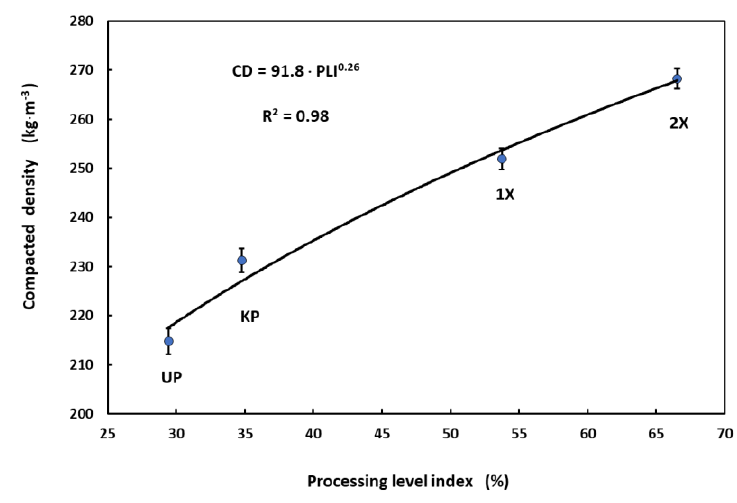
Figure 4. Dry basis compacted density (CD) of the whole-plant versus processing level index (PLI) for the UP, KP, 1X and 2X treatments. Averages from Experiments 1–4 and Experiment 7. Error bars represent the standard error and n = 15.